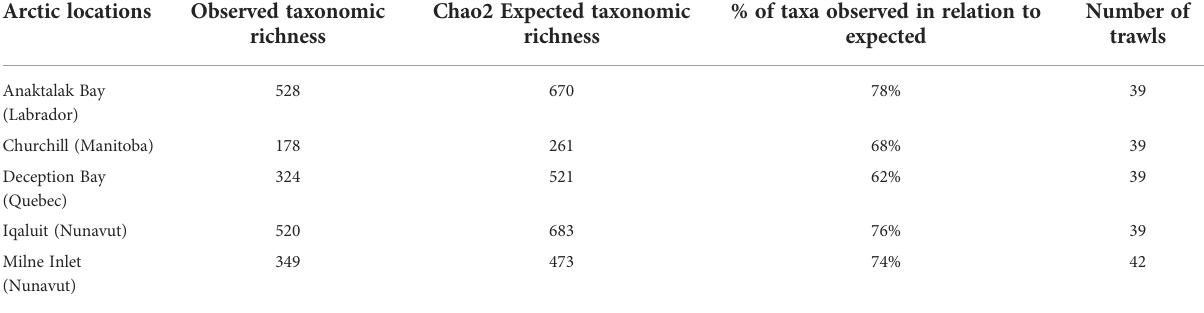
TABLE 1 Number of distinct taxonomic groups observed and expected in each location of the Canadian Arctic and total number of trawls. Arctic